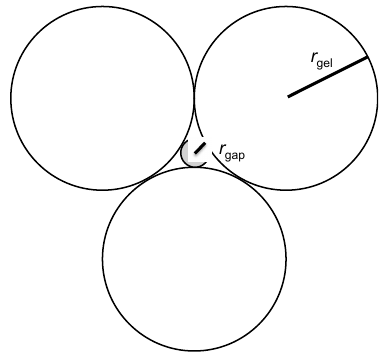
Figure 6. Illustrated image of gels and gaps among gels in closed-packed location of the cross section.